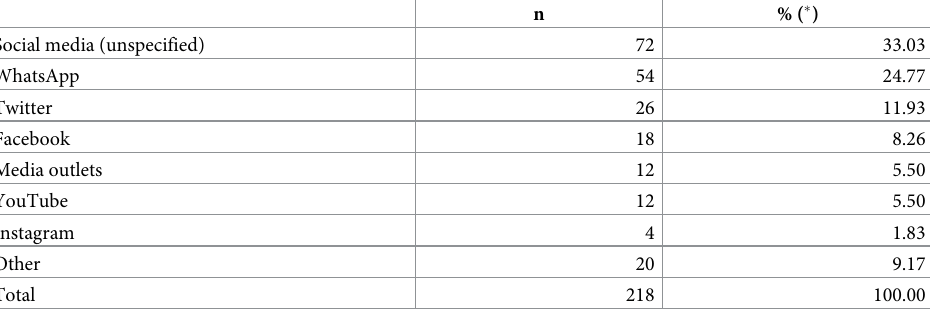
� Percentages are rounded.